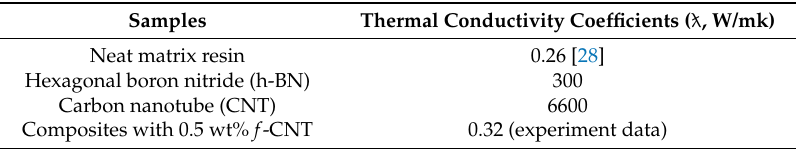
Table 1. Thermal conductivity coefficients of starting